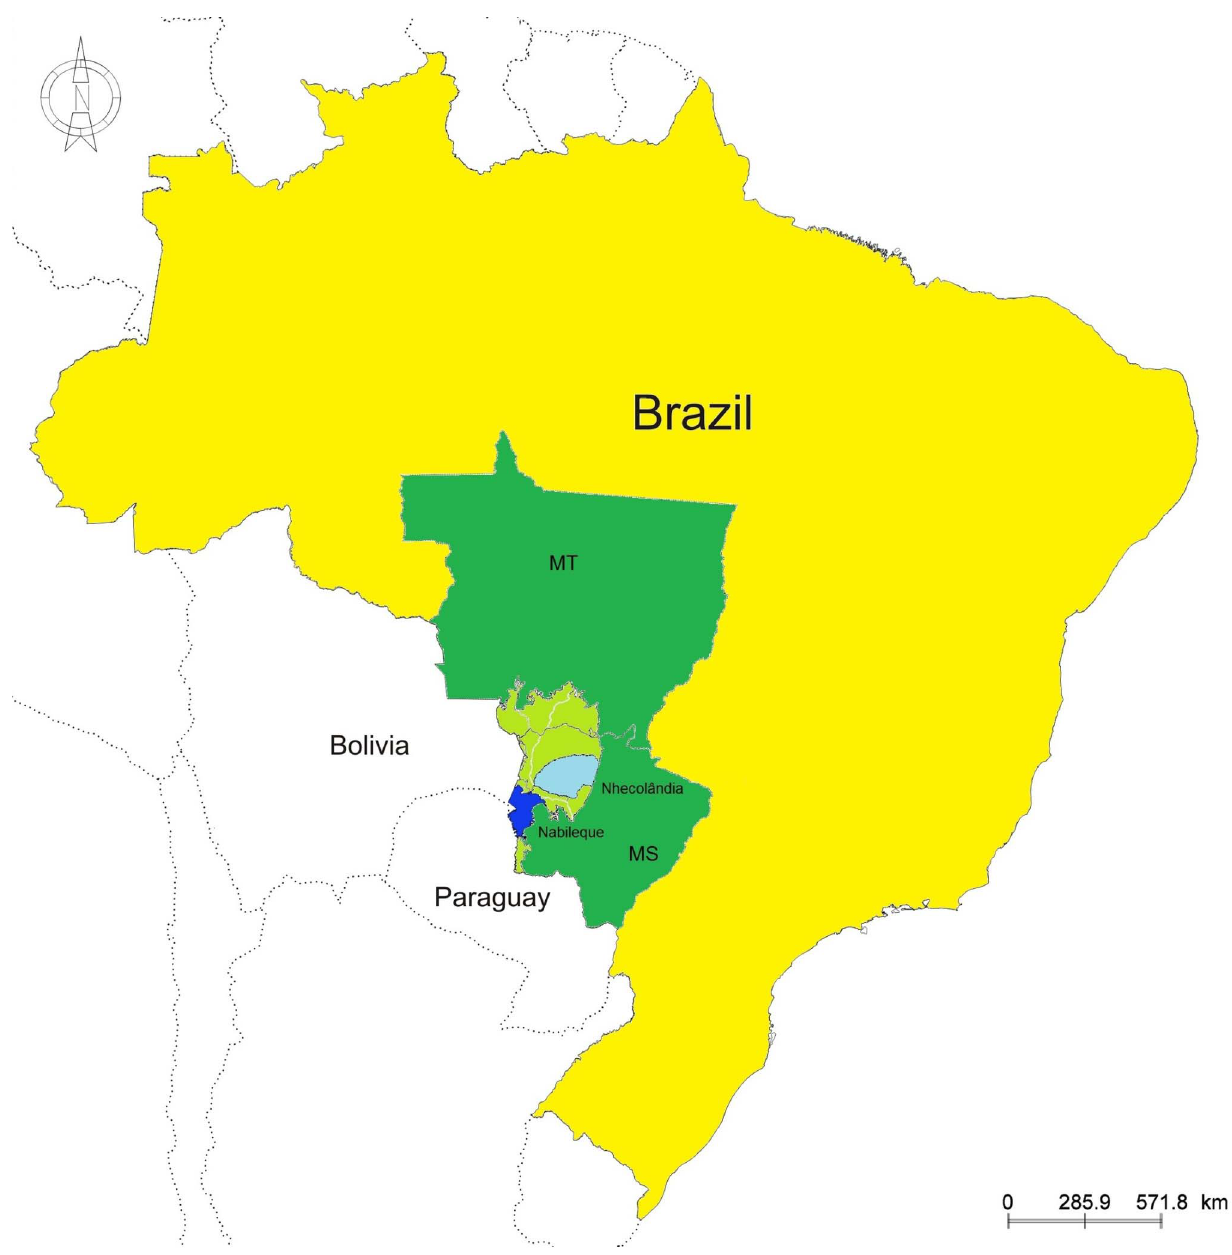
Figure 1. Pantanal located in west-central Brazil. Pantanal located within the states of Mato Grosso (MT) and Mato Grosso do Sul (MS) is shown in light green. Nhecolaˆndia and Nabileque sub-regions, where a serosurvey for flaviviruses was conducted in equines, sheep and caimans in 2009 and 2010 are shown in light and dark blue respectively.